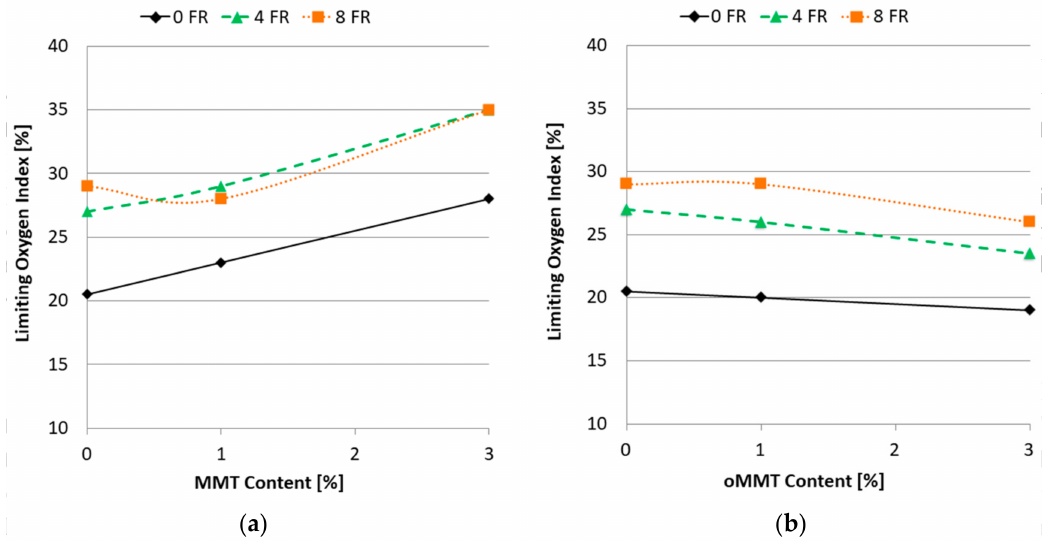
Figure 10. Results of limiting oxygen index (LOI) tests as a function of filler content: ( a ) MMT filler; ( b ) oMMT